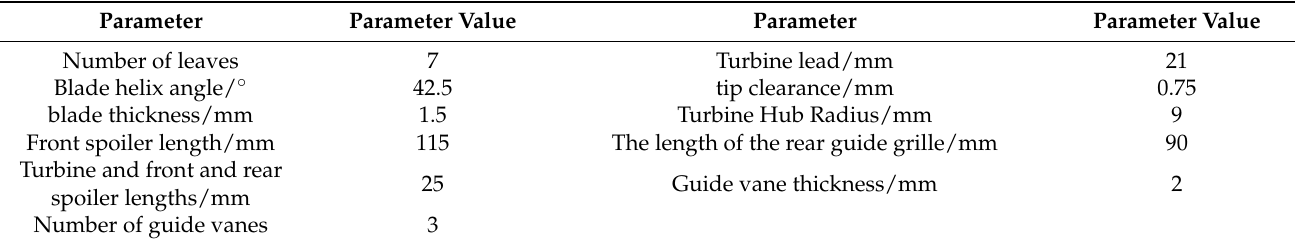
Table 9. Parameter values after system